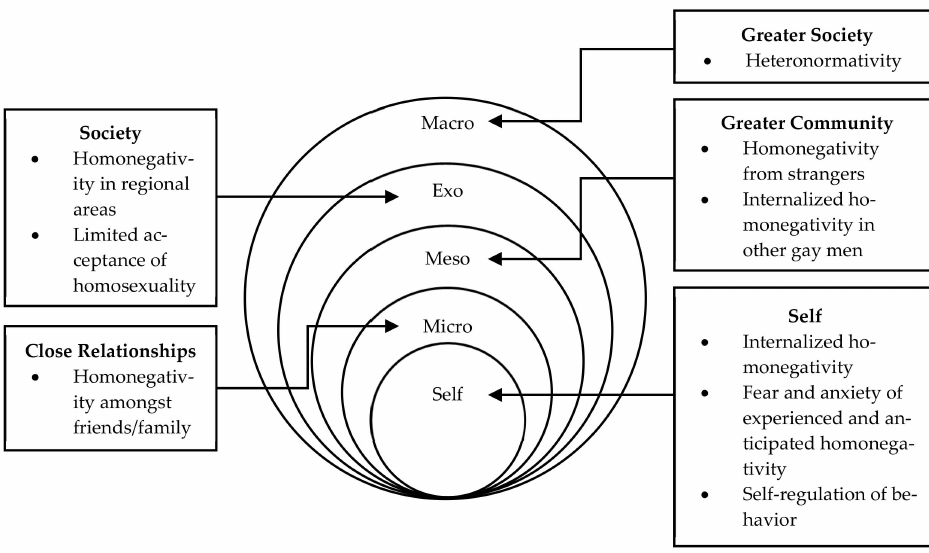
Figure 2. Socio-ecological map of a gay